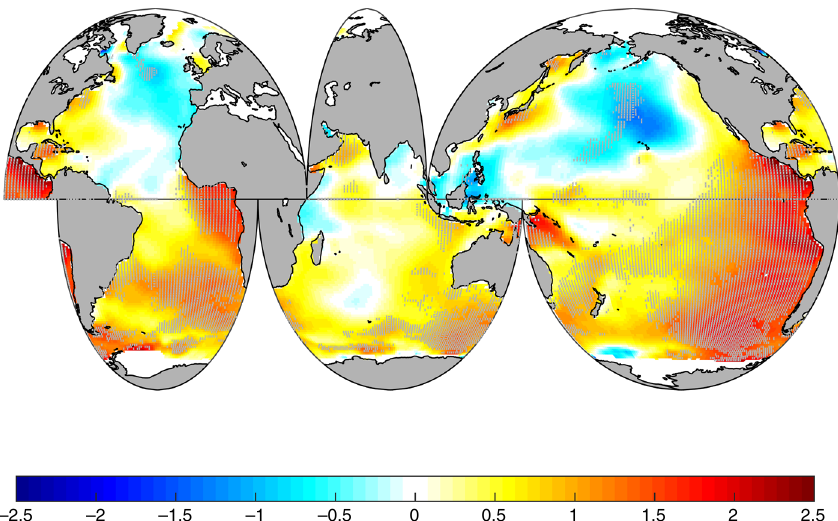
Fig. 6 Spatial trend (percent change per year) in mean Wave Power from 1985 to 2008. Hatched areas represent points that are statistically signi fi cant at the 95% con fi dence level according to the Mann – Kendall test and the Wang and Swail method for autocorrelation (see Methods). The trends are calculated for the period 1985 – 2008 (period with satellite-derived wave data) for comparison with 9 . Supplementary Figure 5 shows the spatial trends